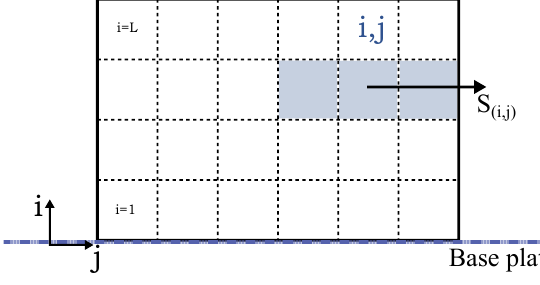
Figure 2. Definition of support region, S ( i , j ) , for the element ( i , j )